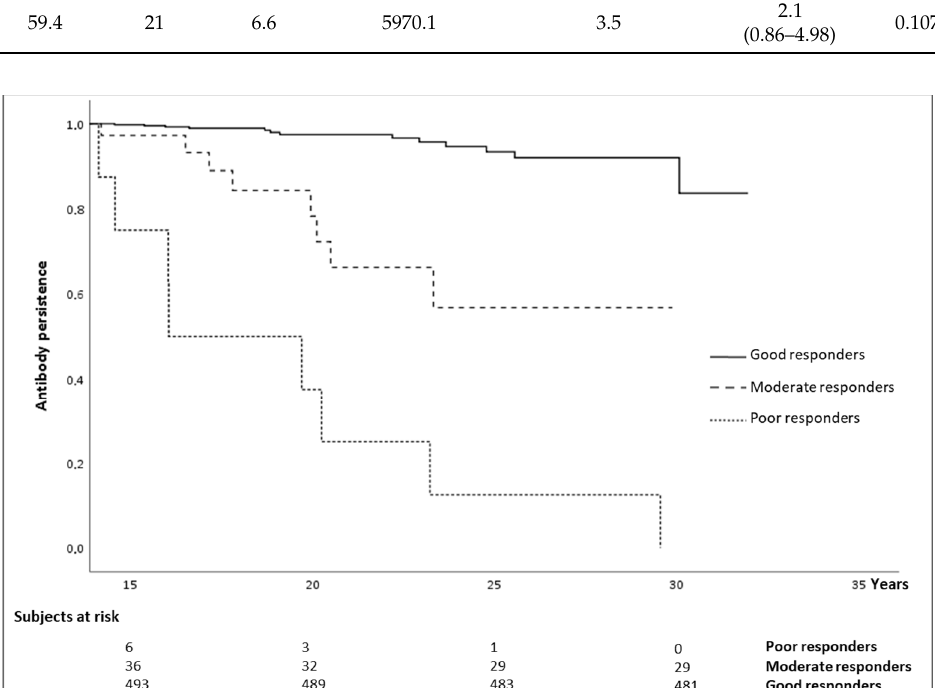
Figure 2. Anti-hepatitis B (HB) persistence by anti-HBs titers after primary